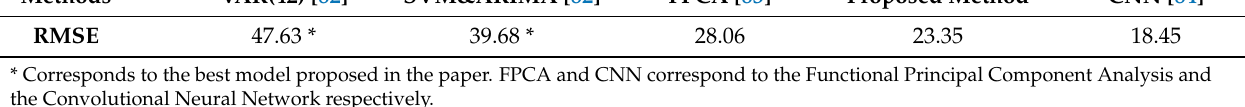
Table 2. Comparisons between the Root Mean Square Error (RMSE) calculated by the proposed approach and other papers.